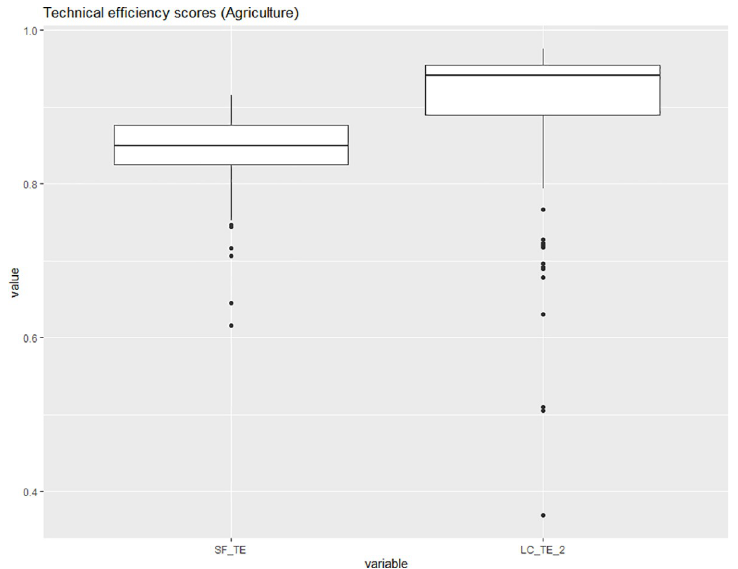
Fig 6. Boxplots of the technical inefficiency scores for the SFM and the LCM (agricultural sciences). Source: own illustration.